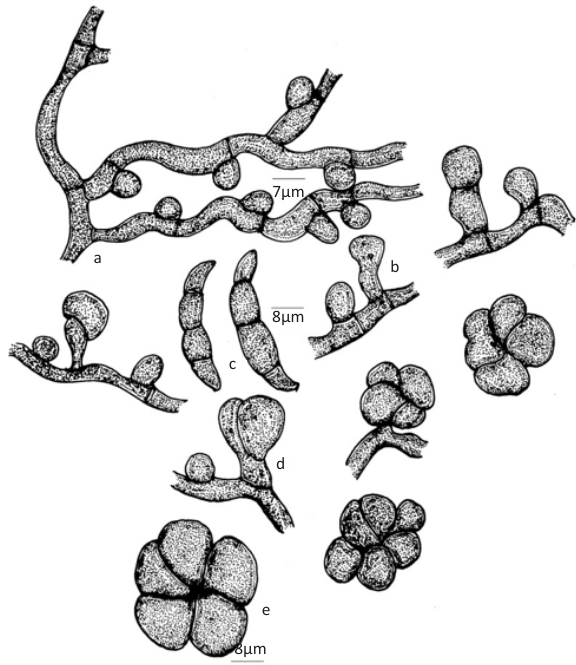
Figure 2. Sarcinella strychni sp. nov.